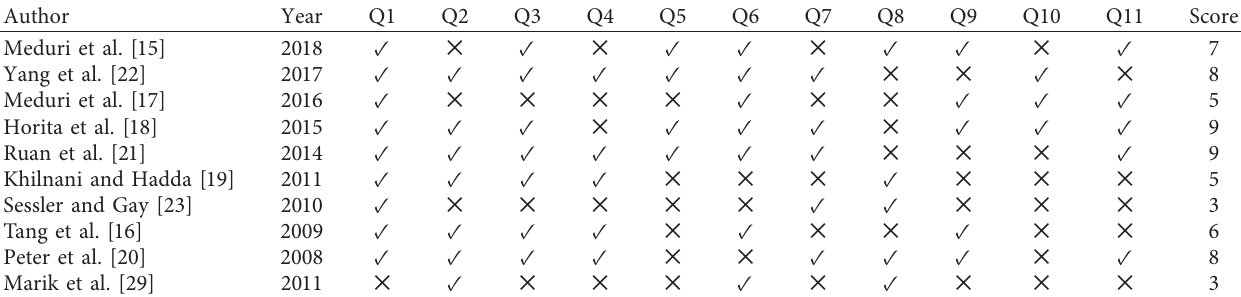
Table 1: Assessment of methodological